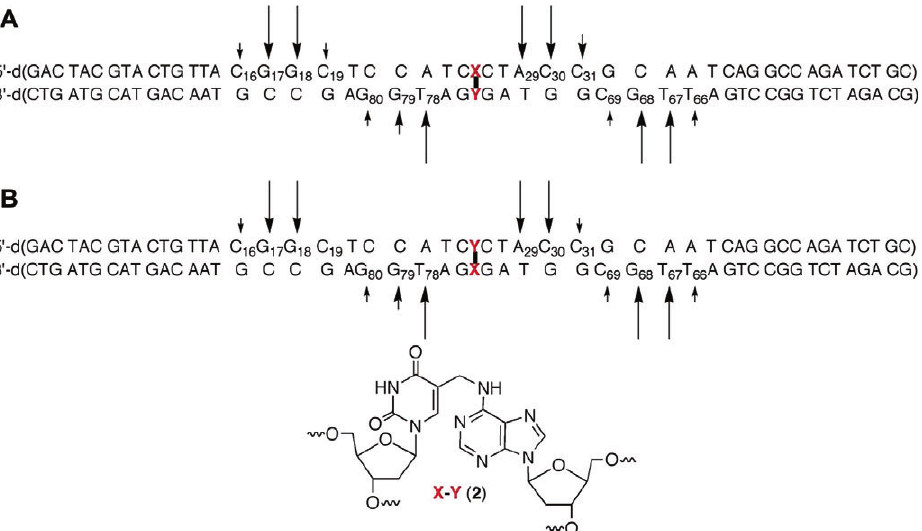
Figure 3 Histograms of UvrABC incision data for the strand containing modified thymidine (X) and the strand containing cross-linked 2 ′ -deoxyadenosine (Y) both labeled at their 3 ′ termini.The histograms compare relative cleavage intensities within a strand but not relative to the complementary strand – the Y-containing strand was generally cleaved faster. In part A, X is flanked by two 2 ′ -deoxycytidines in the sequence, whereas in part B, X is flanked by two 2 ′ -deoxyguanosines. Reprinted with permission from Peng et al. (13) , copyright 2010 American Chemical